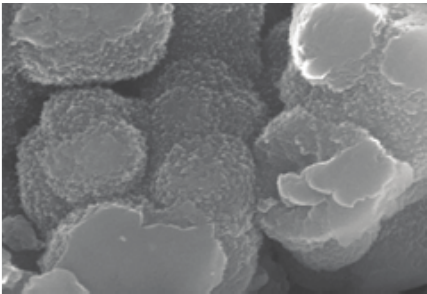
Figure 4: Scanning electron microscope image of the PyP.